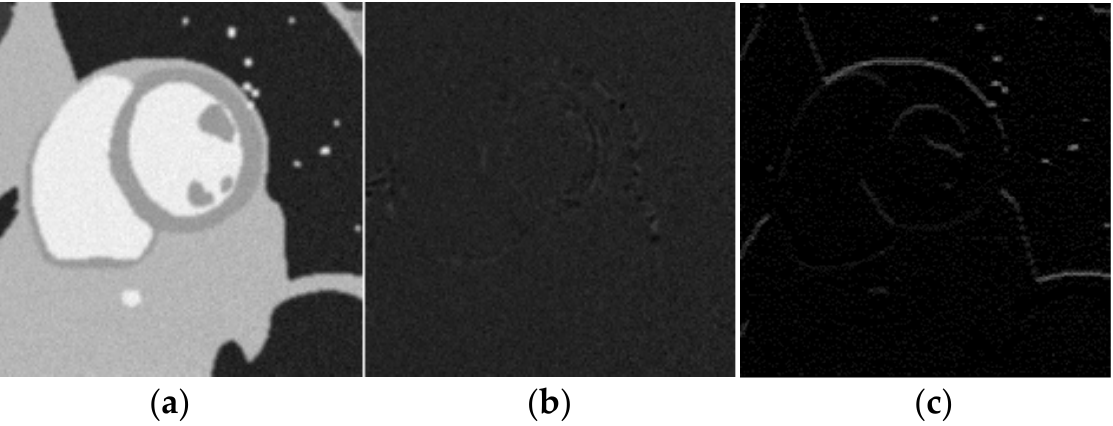
Figure 11. ( a ) Short axis cardiac cine MRI with completely sampled diastolic frame. ( b ) Sparsifying